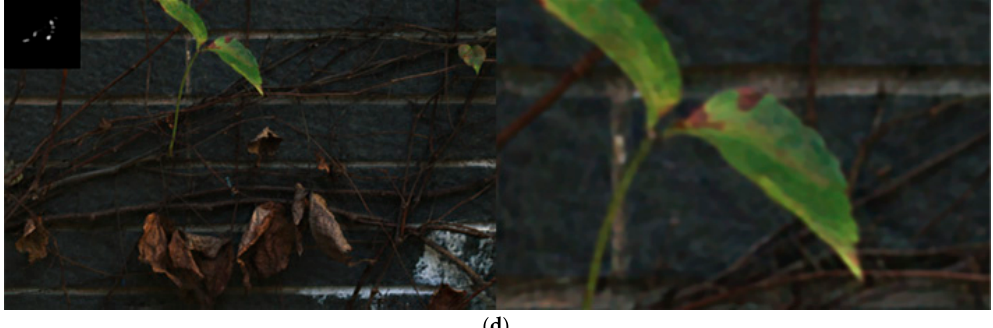
Figure 12. Comparison of different restoration algorithms on the wall image with large blur. ( a ) Real burred image; ( b ) result of Fergus et al. [3]; ( c ) result of Shan et al. [4]; and ( d ) our result. The size of our estimated blur kernel is 95 × 95.